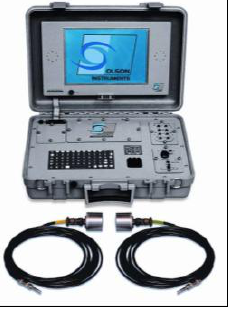
Figure 7. Olson Instruments’ UPV and field ruggedized computer system Rebar Location: Portable, quick system for detecting rebar location, direction, and diameter within concrete structures.